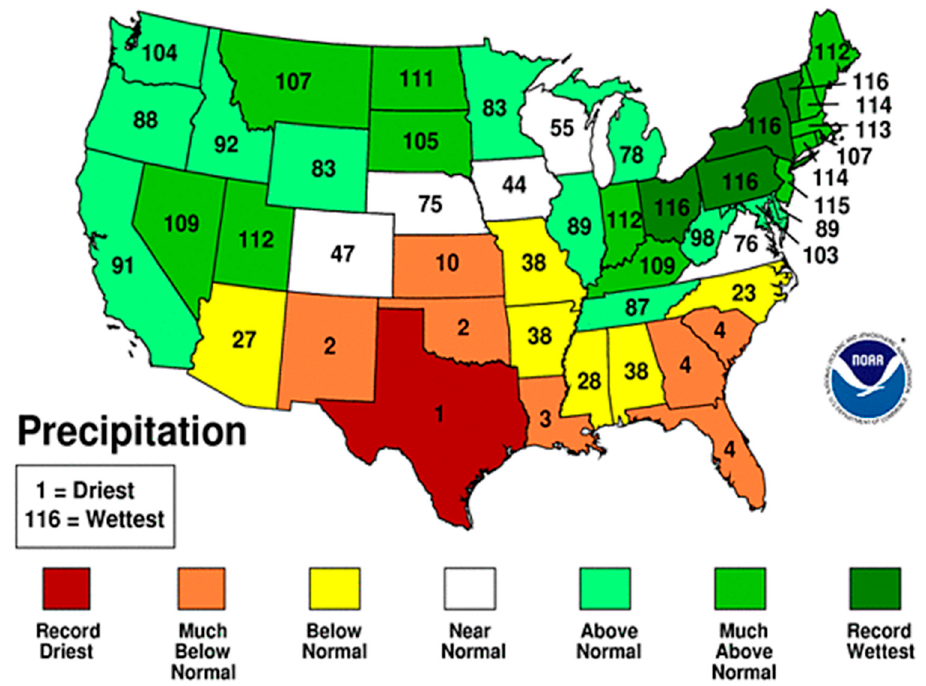
Figure 1. US statewide precipitation ranks (October 2010–September 2011). Source: National Oceanic and Atmospheric Administration [5].